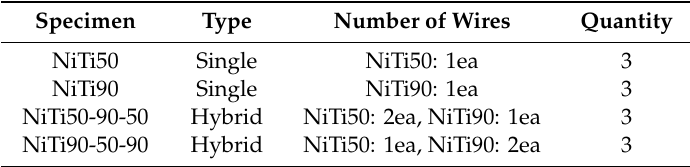
Figure 4. Details of specimens: ( a ) unbent hybrid SMA wire and bent hybrid SMA wire; ( b ) section of specimen at wire clip.